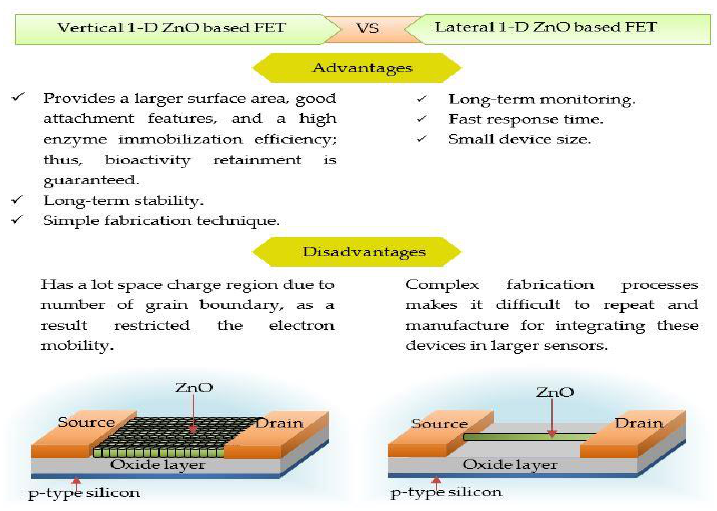
Figure 10. Schematic diagram of vertical and lateral 1-D ZnO-based FET biosensor with advantages and disadvantages.